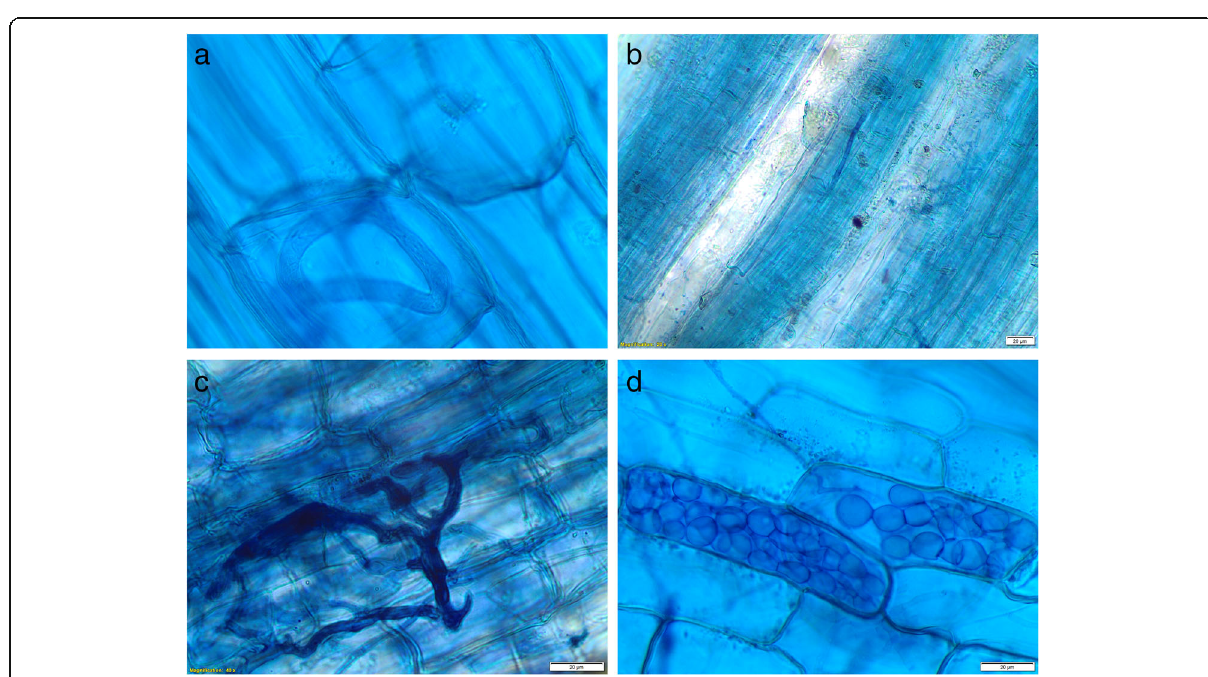
Fig. 3 Root colonization by AMF ( a , c ) and DSE ( b , d ) in the roots of R. columnifera (top) and V. encelioides (bottom) plants treated with microbial